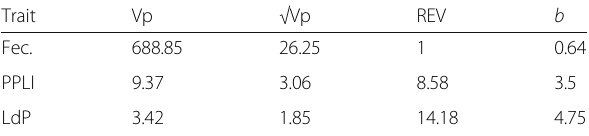
Table 4 Economic values of the fecundity, between preying potential of the 3 rd larval instar and the larval developmental